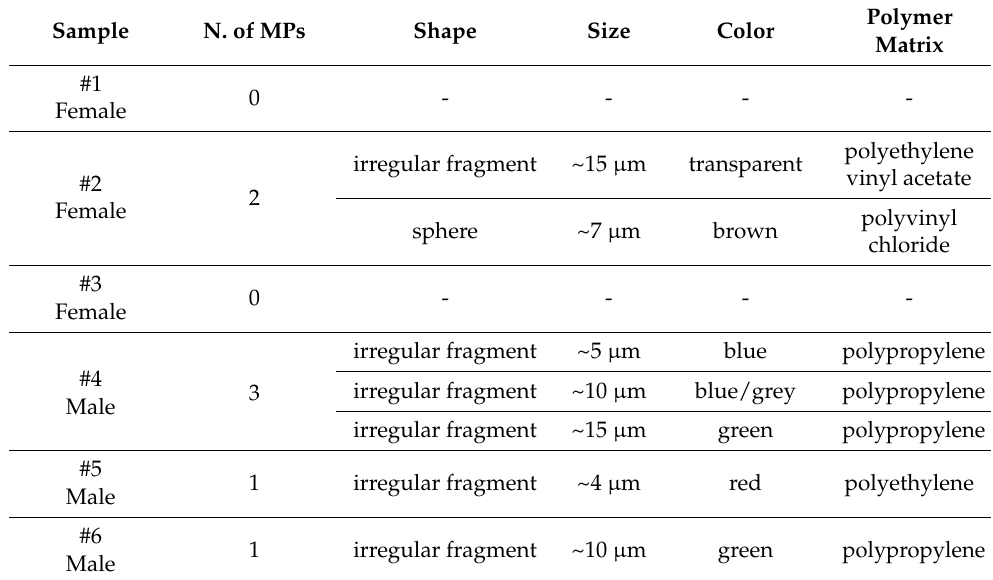
Table 1. MPs presence in individual samples, including morphology, size, color, and polymer ma- trix.